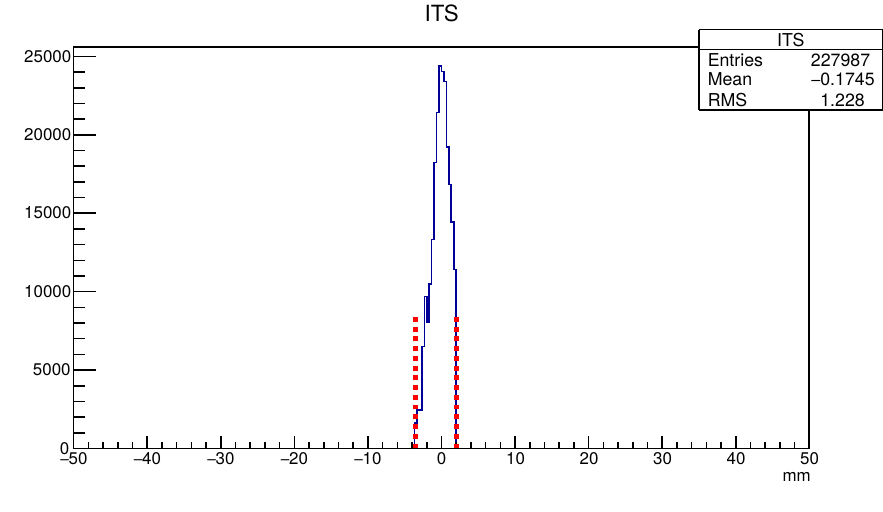
Figure 1. The internal target position selection window